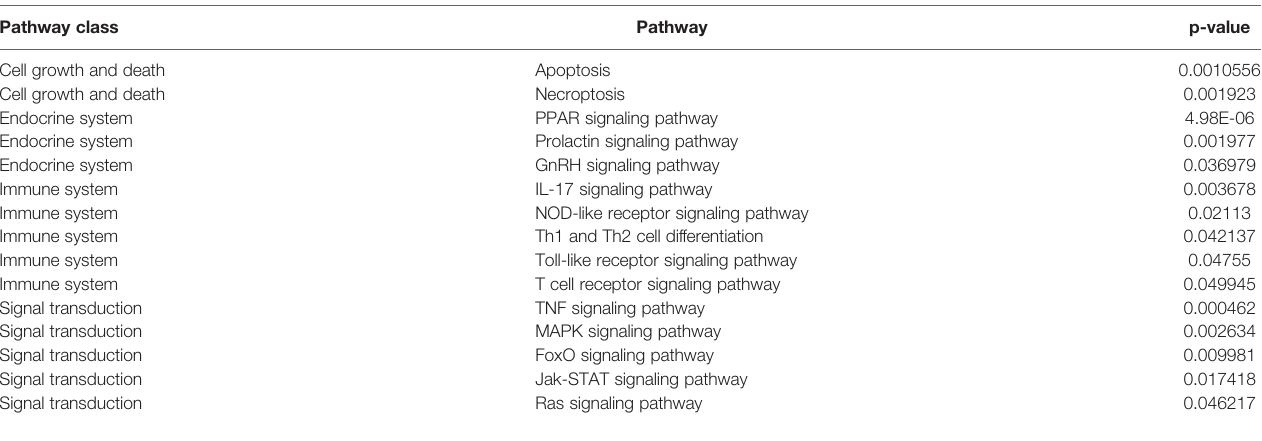
TABLE 1 | The KEGG results.